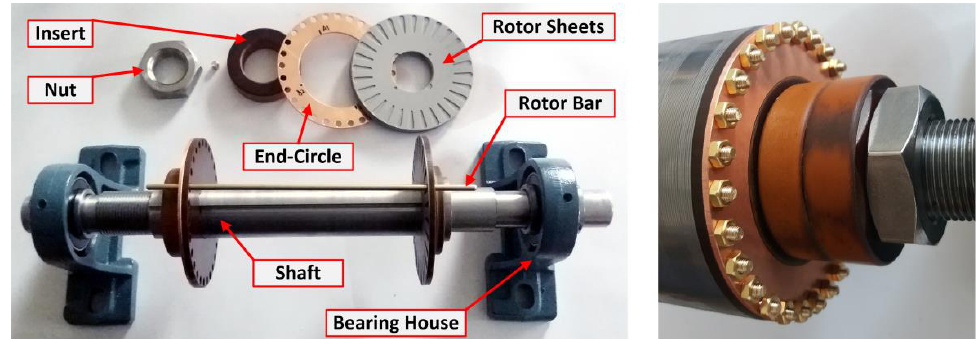
Figure 10. The test rotor set with individual components.